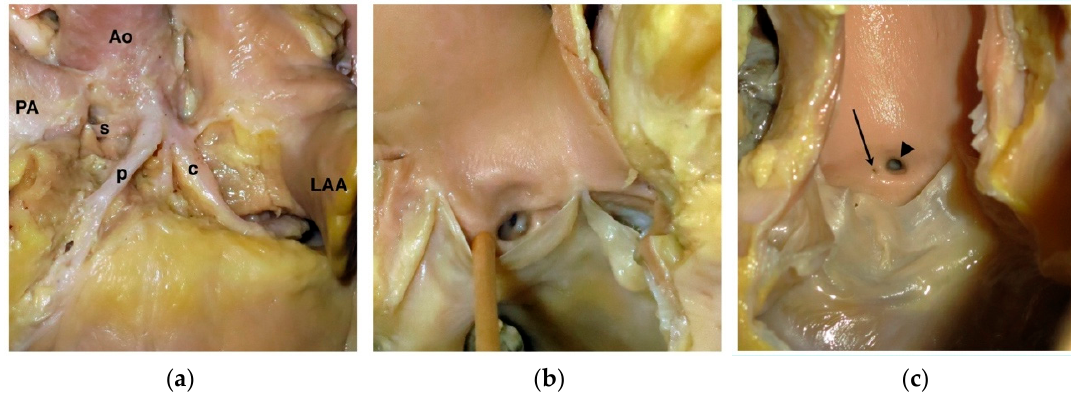
Figure 2. Variations of normal coronary ostia in the dog. ( a ) Left coronary trifurcation in a dog with a very short (nearly absent) left main coronary artery in whom the left coronary ostium gives rise to a septal branch (s), paraconal interventricular branch (p), and a circumflex branch (c). Ao = aorta; LAA = left auricular appendage; PA = pulmonary artery. ( b ) View of the left aortic valvar sinus from the dog in panel (a) showing the trifurcation of the left coronary system. ( c ) Photograph of the right aortic valvar sinus from a different dog showing a right coronary ostium (arrowhead) with an additional small ostium (arrow) consistent with the right accessory or conus branch.